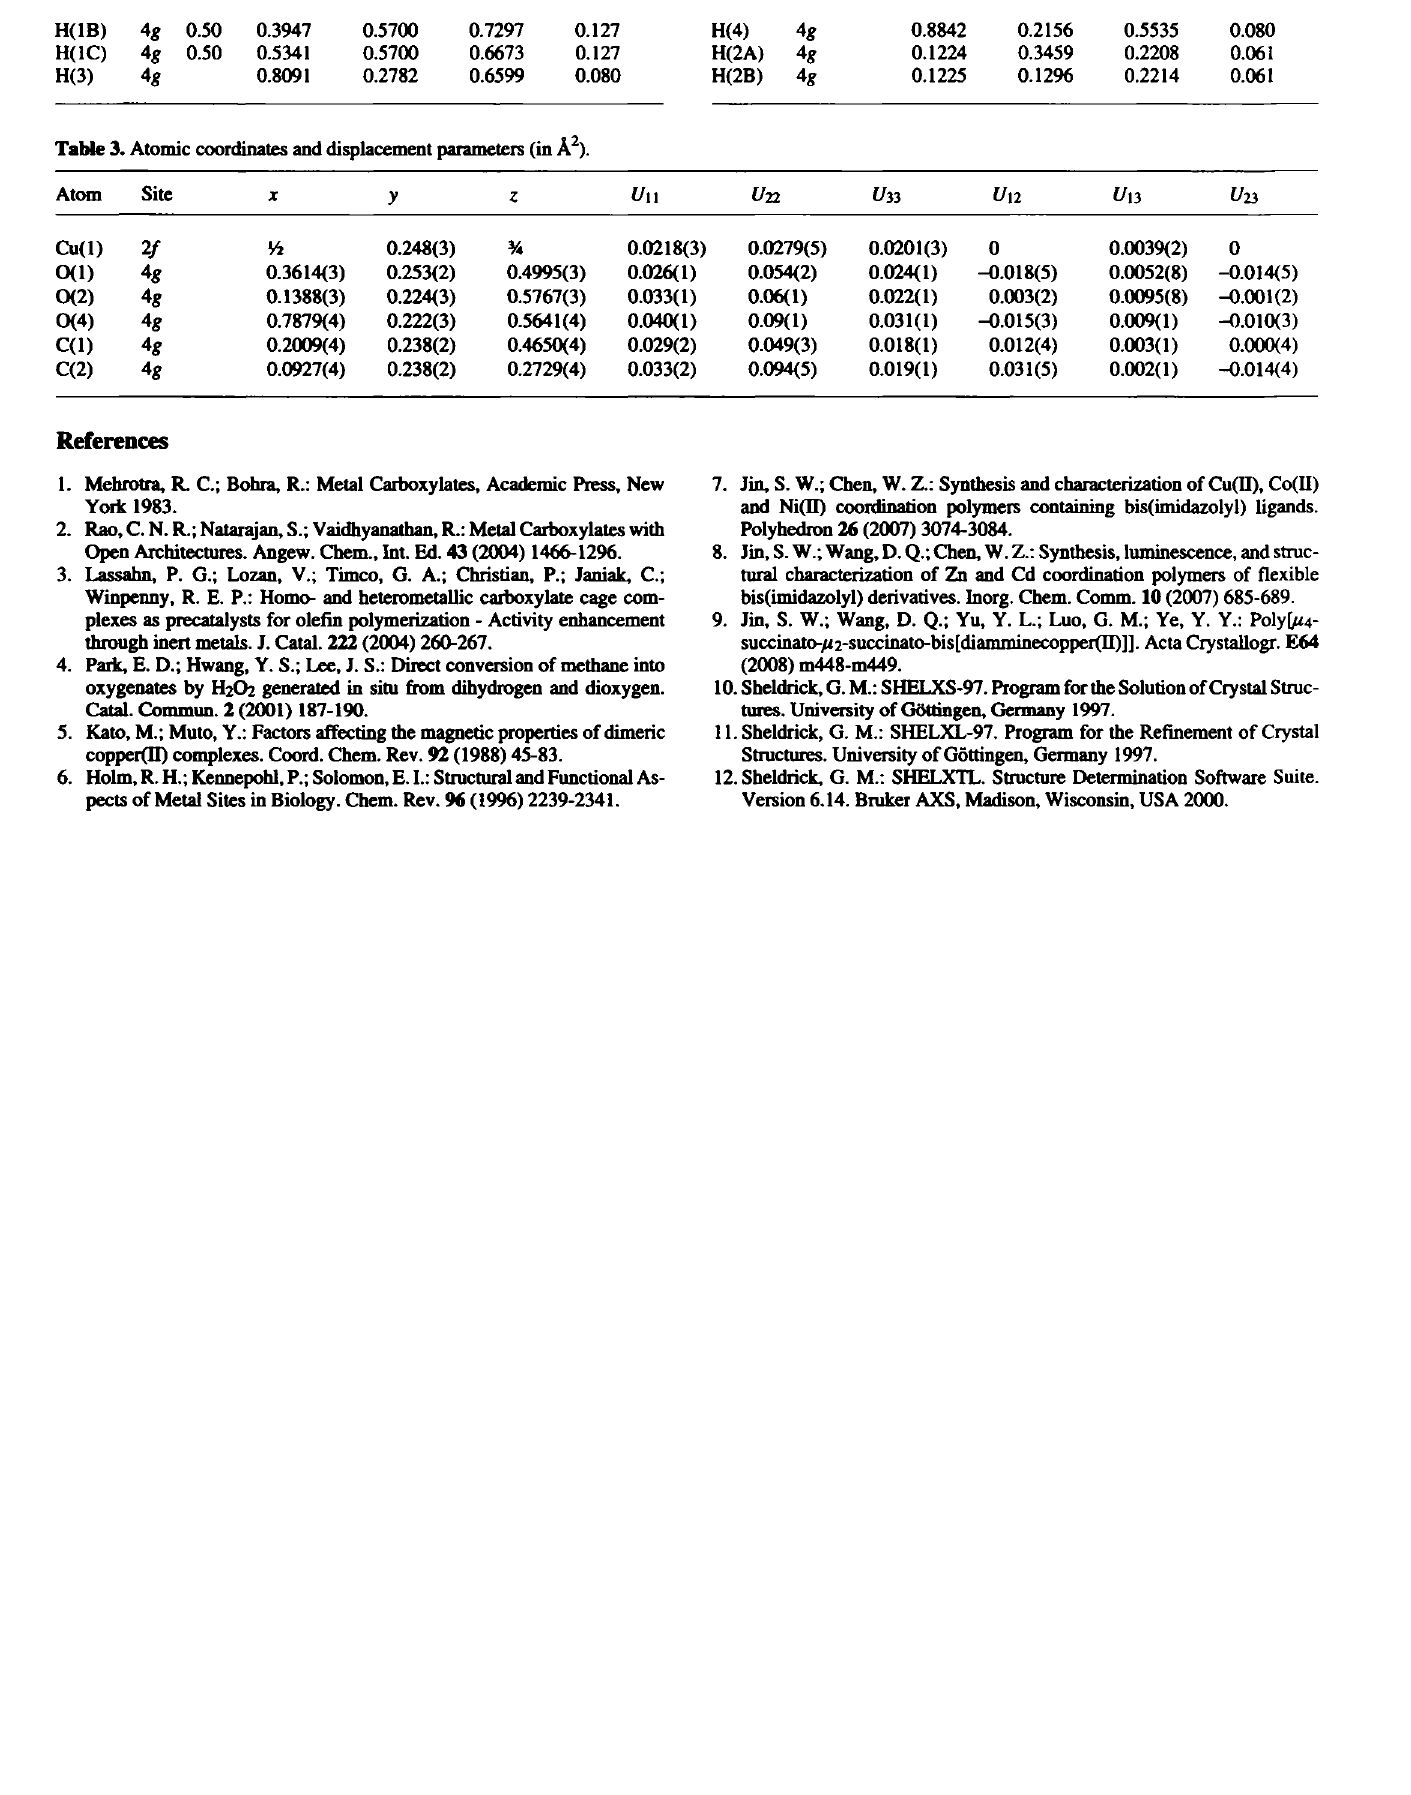
Table 3. Atomic coordinates and displacement parameters (in Â 2